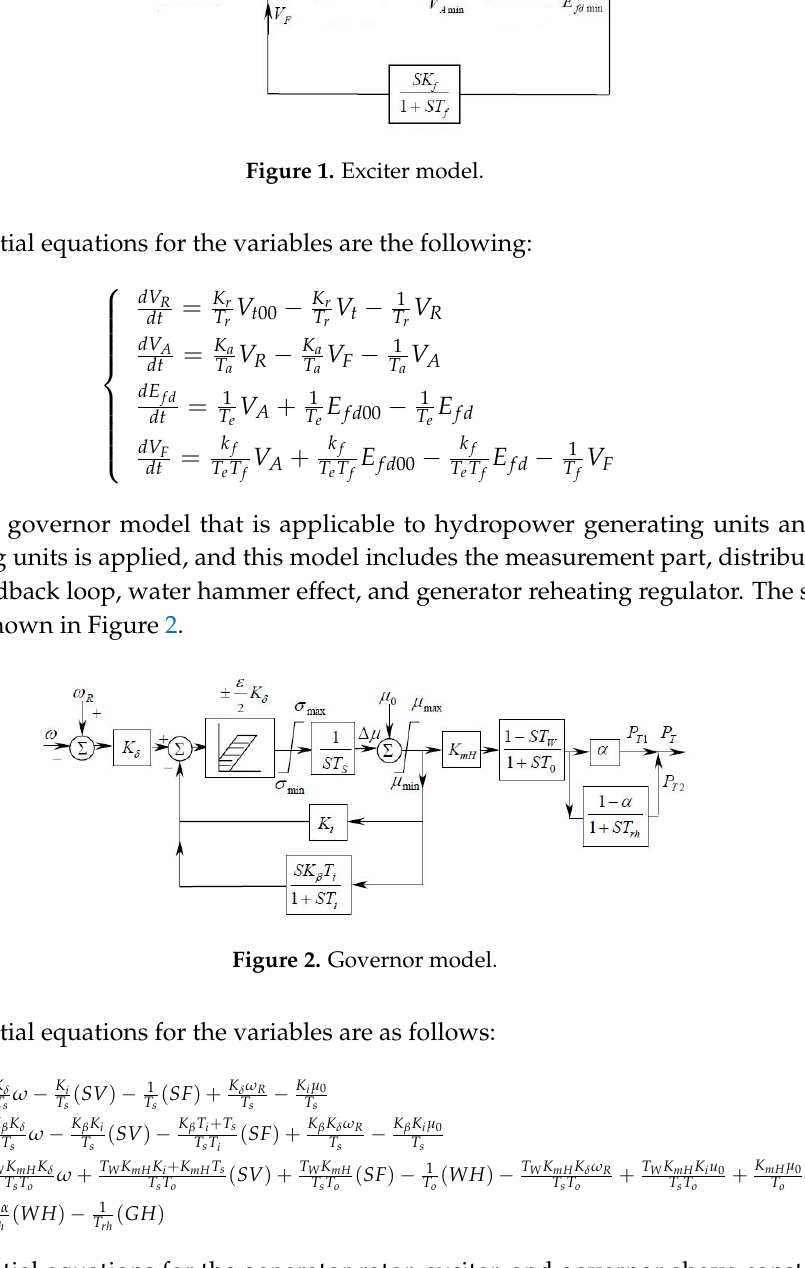
Figure 1. Exciter model.